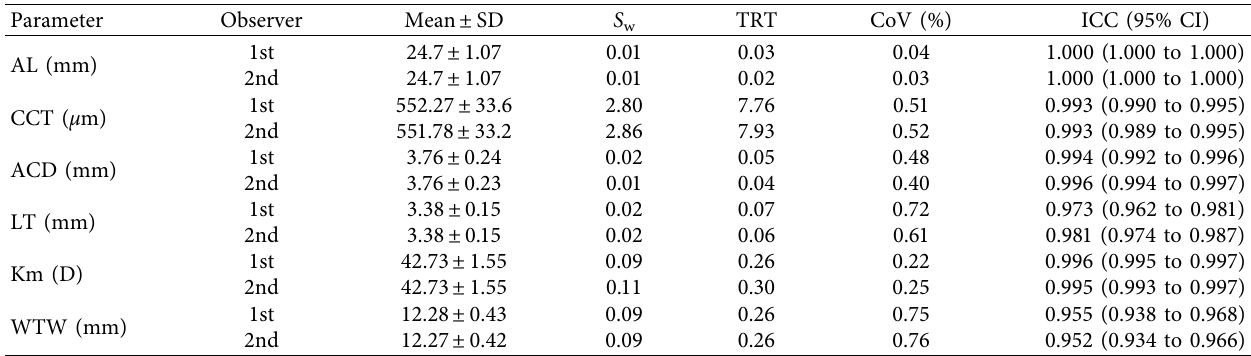
Table 1: Intraobserver repeatability outcomes for biometric measurements obtained using IOLMaster 700 swept-source optical coherence tomography in children.